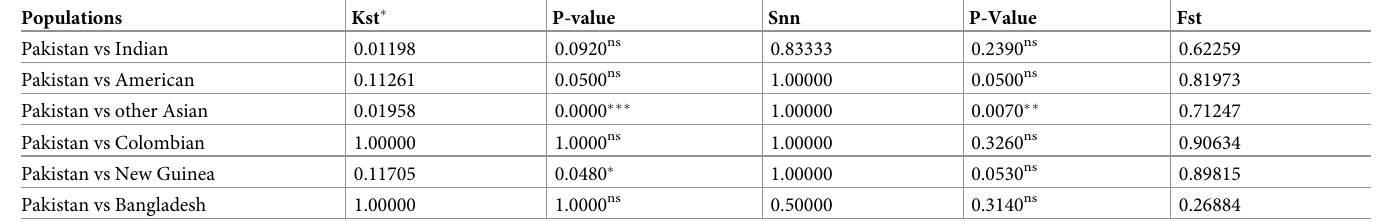
standardized variance in allele frequencies across populations) was used to access the gene flow level. Two subpopulations were created to compare the differences. Considering the data (Table 1) the Fst values generated between the populations based on the PRSV-CP isolates were above 0.33 except the values between populations of PK vs Bangladesh (0.26720) and PK vs India (0.32051). The descending order of Fst values between different populations includes PK vs Australian (0.75410), PK vs Colombian (0.7502), PK vs American (0.64828), PK vs other Asian isolates (China, Taiwan and Thailand) (0.61615), and PK vs Mexican (0.61422), depicts that there exists a significant genetic differentiation between these populations. The estimation of genetic differentiation and gene flow between populations using CP gene sequences are shown in Table 1. The descending order of Fst values calculated between PRSV-PK virus population with rest of 6 populations form different geographical regions based on full genomes includes, PK vs Colombia (0.90634), PK vs New-Guinea (0.89815), PK vs America (0.81973), PK vs Other Asian regions (0.71247), PK vs India (0.62259) and PK vs Bangladesh (0.26884). The estima- tion of genetic differentiation and gene flow between PRSV-PK populations with rest of the populations based on full genome sequences is mentioned in Table 2. Table 2. Statistical tests for genetic differentiation and gene flow between Papaya ringspot virus populations from Pakistan with the populations from Colombia, Mexico, America, other Asian regions, Bangladesh, New Guinea and India based on the full-length genomic sequences.